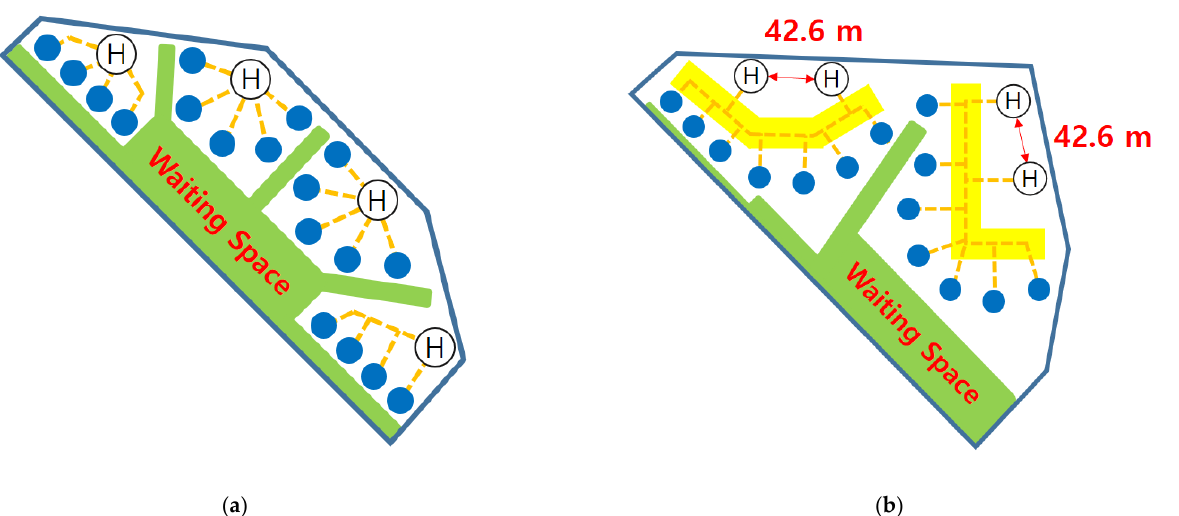
Figure 20. Satellite topologies for the Gimpo Airport parking lot that comply with the EASA’s new regulations: ( a ) current parking space; ( b ) expanded parking space.